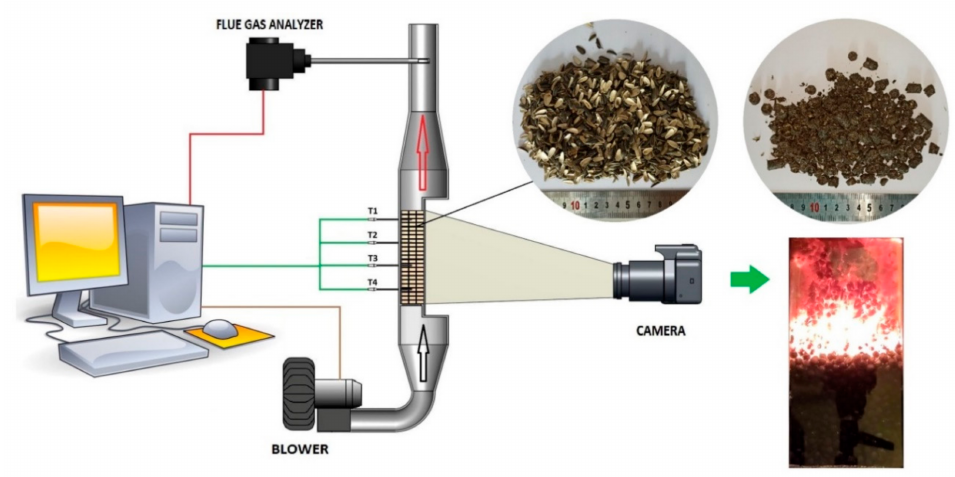
Figure 1. Test stand for the combustion